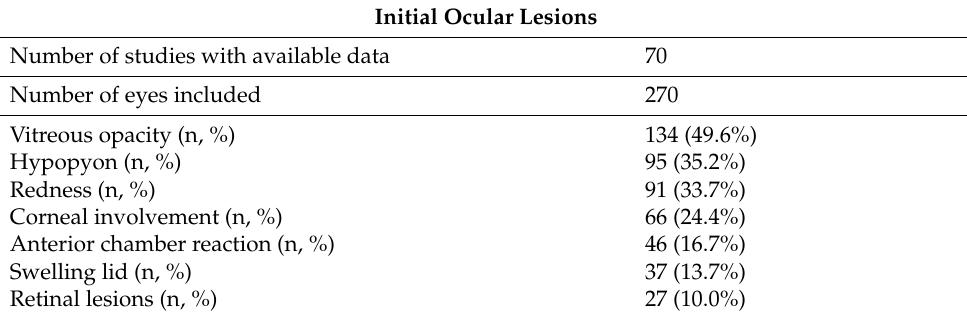
Table 4. Initial ocular